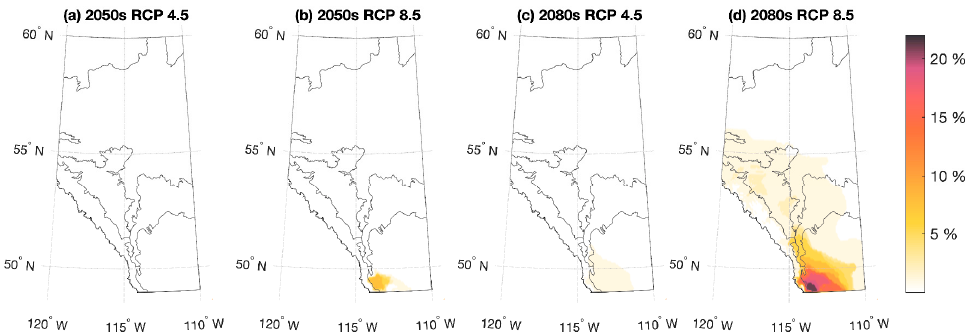
Figure 8. Percentage of winters projected to remain above freezing, where no autumn or spring 0 °C isotherm is detected.